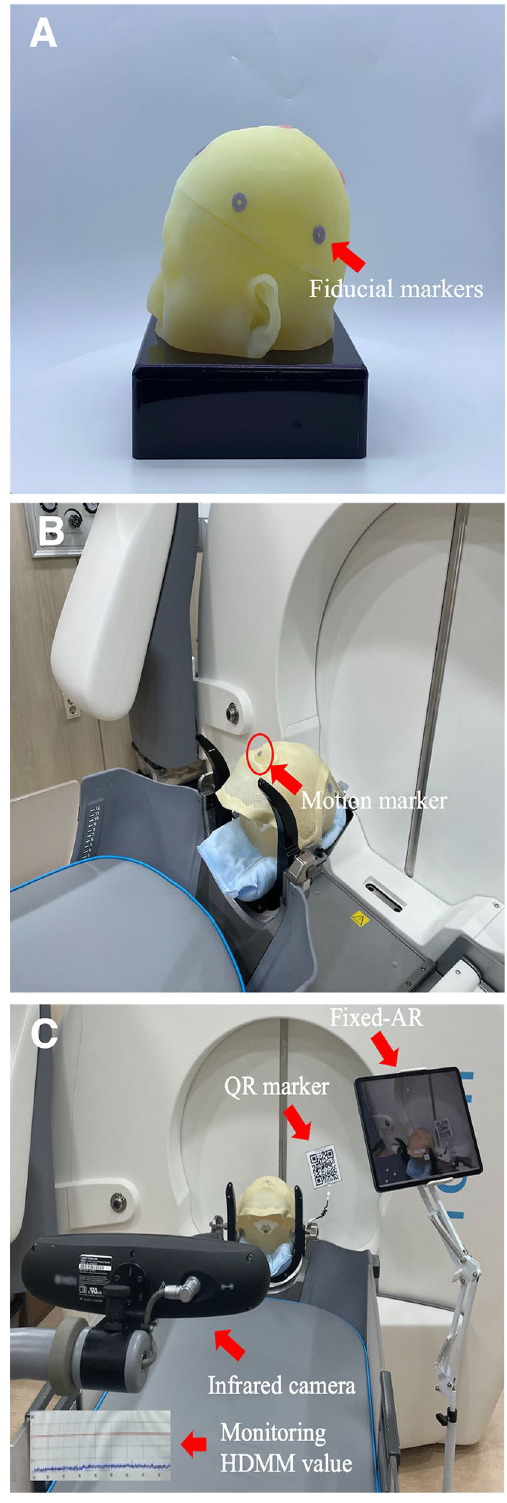
Figure 2. The fixed-AR execution prepared in the frameless fixation adaptor for GKRS. The 3D-printed patient model included fiducial markers ( A ). The 3D-printed model had a frameless adaptor with the motion marker ( B ). Implemented fixed-AR with the QR marker being monitored under the infrared camera ( C ). Quick Response, QR; Augmented Reality, AR; high-definition motion monitoring,